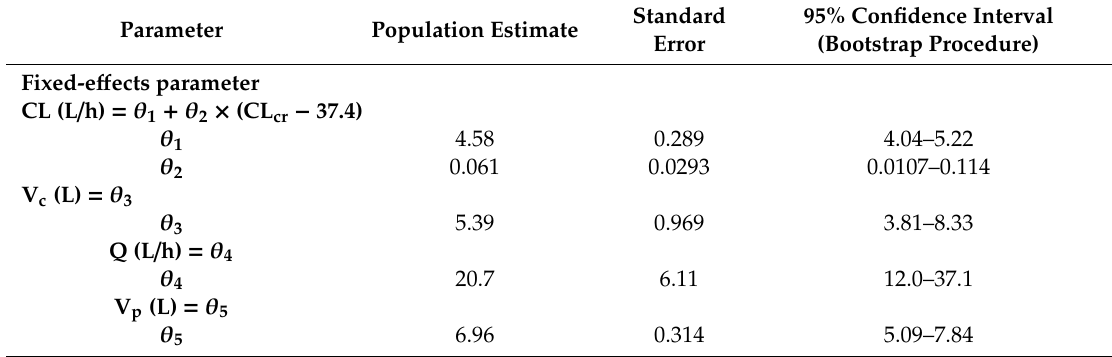
Table 2. Estimate of population pharmacokinetic (PK) parameters of piperacillin (PIPC) in the final